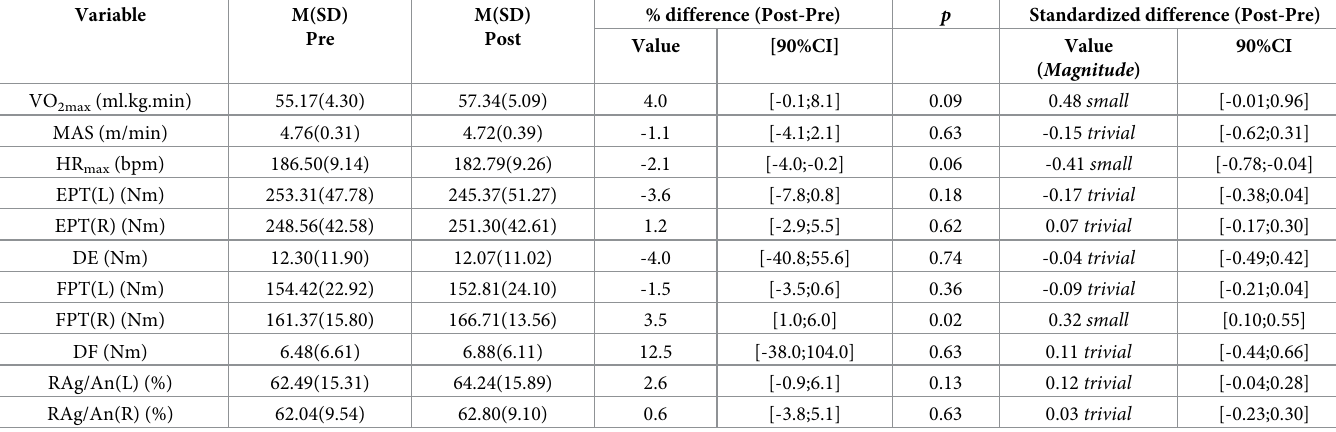
Table 2. Within-group differences of VO 2max , MAS, and isokinetic strength between pre- and post-period of training. VO 2max : maximal oxygen consumption; MAS: maximal aerobic speed; HR max : maximal heart rate; EPT: Extension Peak Torque at 60˚/s; FPT: flexion peak torque at 60˚/s; (L): left; (R): right; DE: deficit at extension; DF: deficit at flexion; Rag/An: ratio agonist/antagonist.